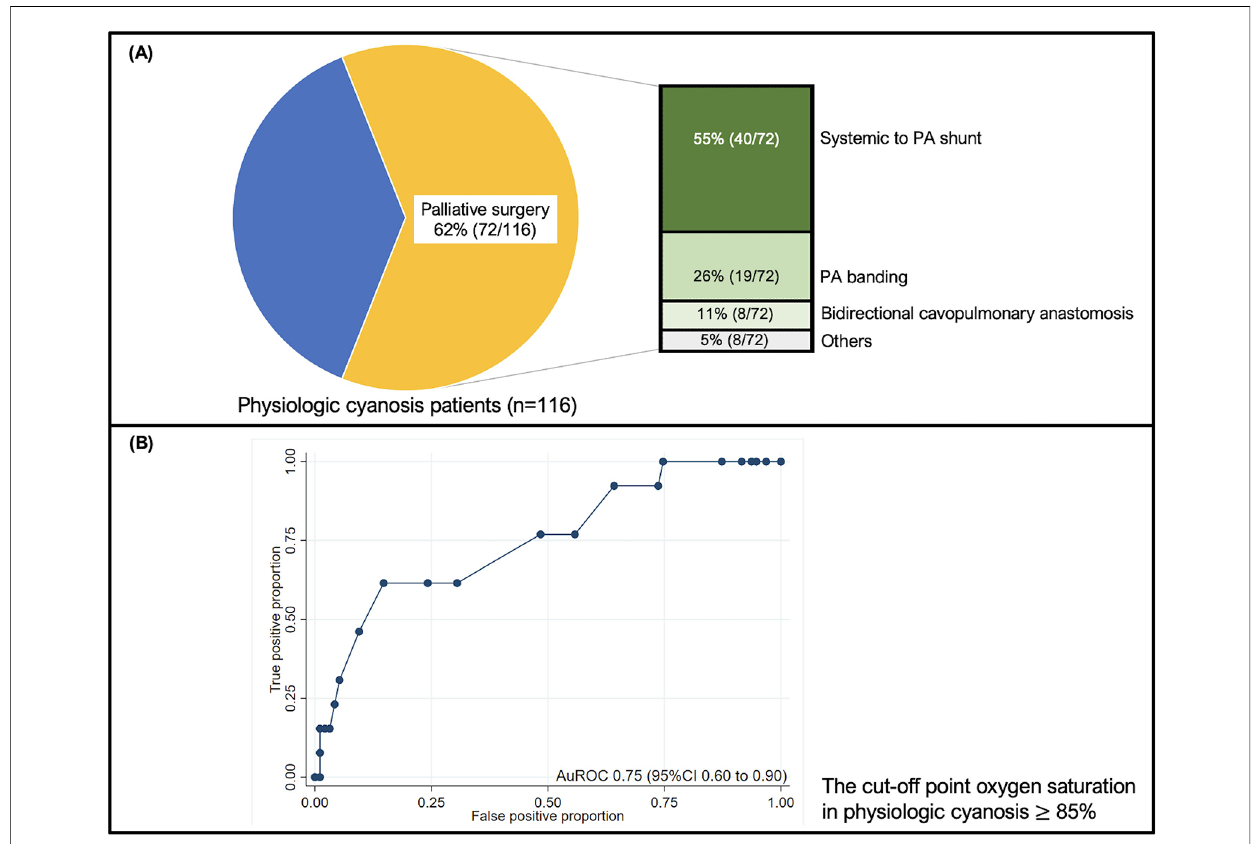
FIGURE 2 (A) The pie chart shows the proportion of patients with physiologic cyanosis who underwent palliative surgery. The number of patients who underwent surgery is presented in a bar graph; (B) The ROC graph illustrates the discrimination of SpO 2 in predicting extubation failure in physiologic cyanosis. The cut-off point oxygen saturation in physiologic cyanosis 85%, and the sensitivity and speci fi city were 76.92% and 51.56%, respectively. The ROC curve shows 0.75 (95% CI 0.60 – 0.90). CI: con fi dence interval; PA: pulmonary artery; ROC: the receiver operating characteristic curve; SpO 2 : oxygen